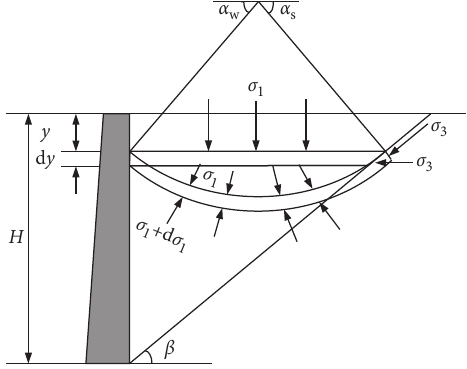
Figure 1: Arch shape of small principal stress.